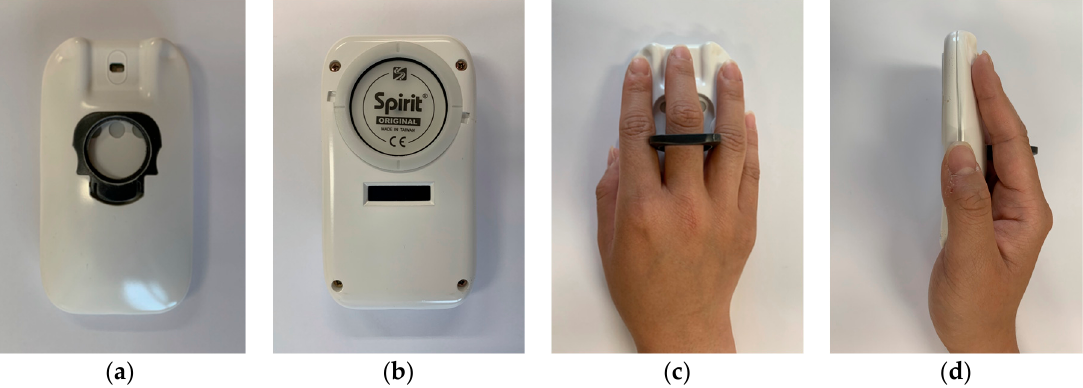
Figure 4. Pictures of assembled proposed multimodal smart stethoscope prototype: ( a ) top view of the prototype’s top; ( b ) top view of the prototype’s bottom; ( c ) top view of grasping the prototype; ( d ) side view of grasping the prototype.